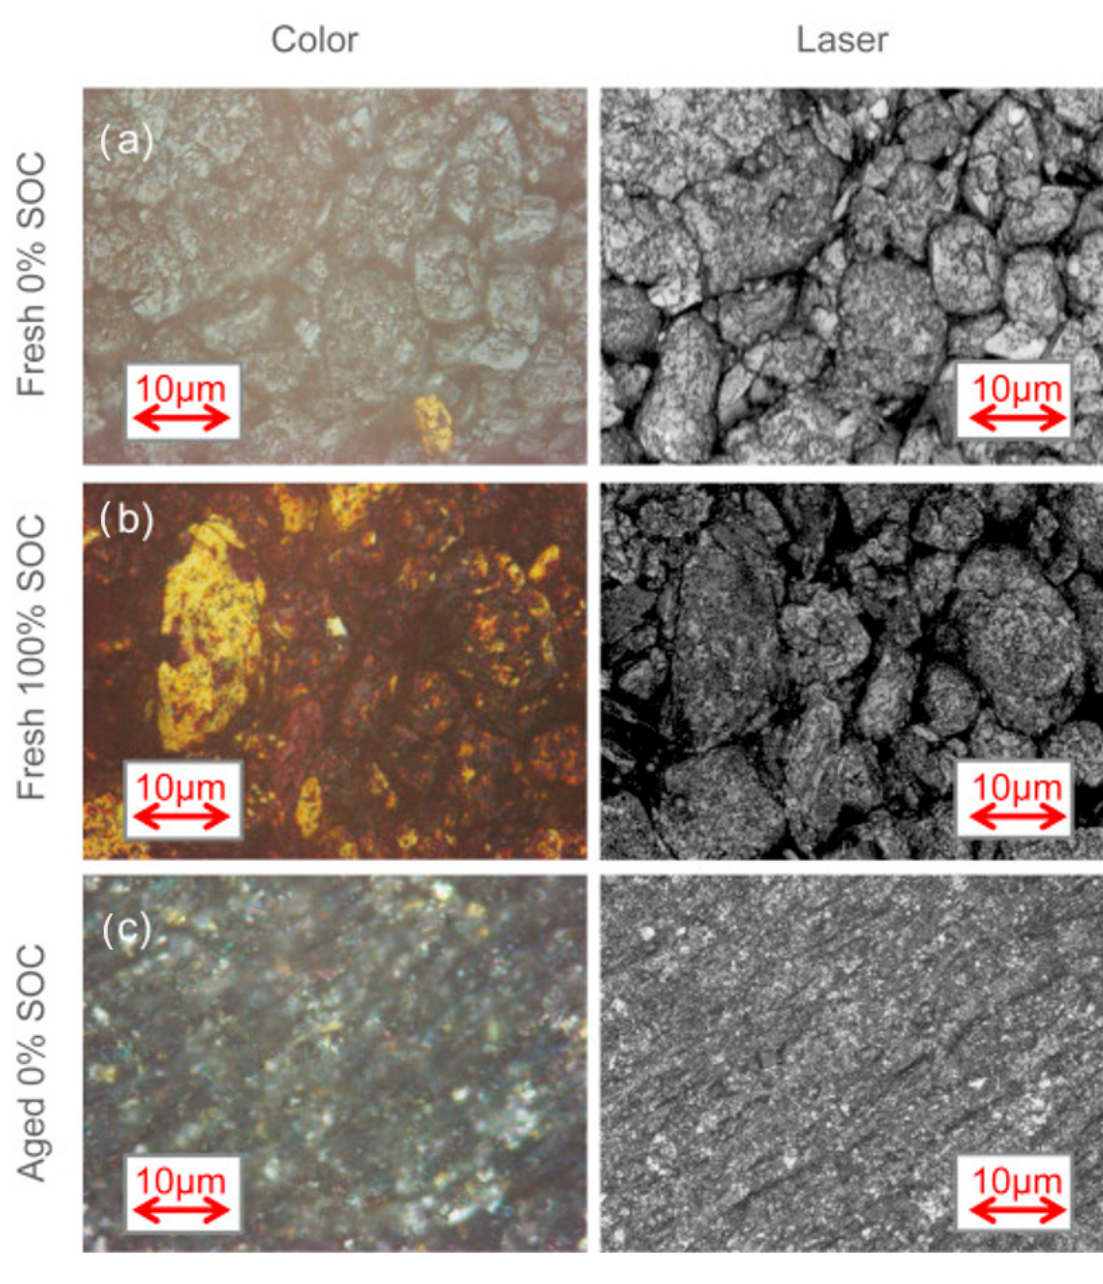
Figure 10. Laser microscope images of ( a ) a fresh cell at 0% SOC; ( b ) a fresh cell at 100% SOC; ( c ) an aged cell at 1C and 10% DOD, which can be observed covering a thick layer [65]. Reprint with permission [65]; Copyright 2017,